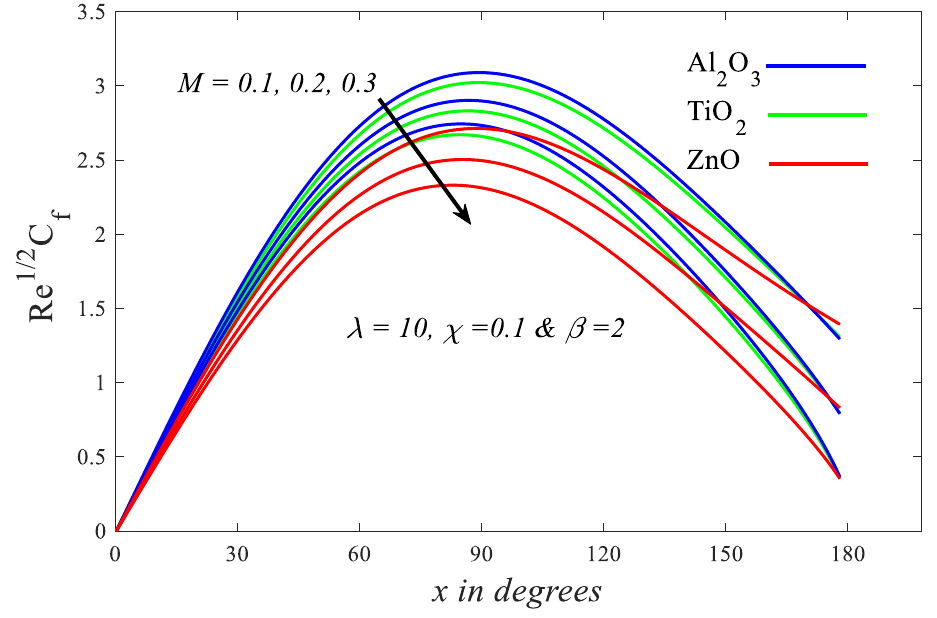
C . Figure 9. Impression of M on Re 1/2 C f . Figure 9. Impression of M on 1/2 Re f Figures 10 and 11 illustrate the effect of the combined convection parameter on temper- ature and velocity, respectively. It is noticed here that by improving the mixed convection parameter, the temperature declines while the velocity grows. This growth in velocity or decline in temperature is due to an increase in the buoyancy force caused by an increase in the mixed convection parameter.